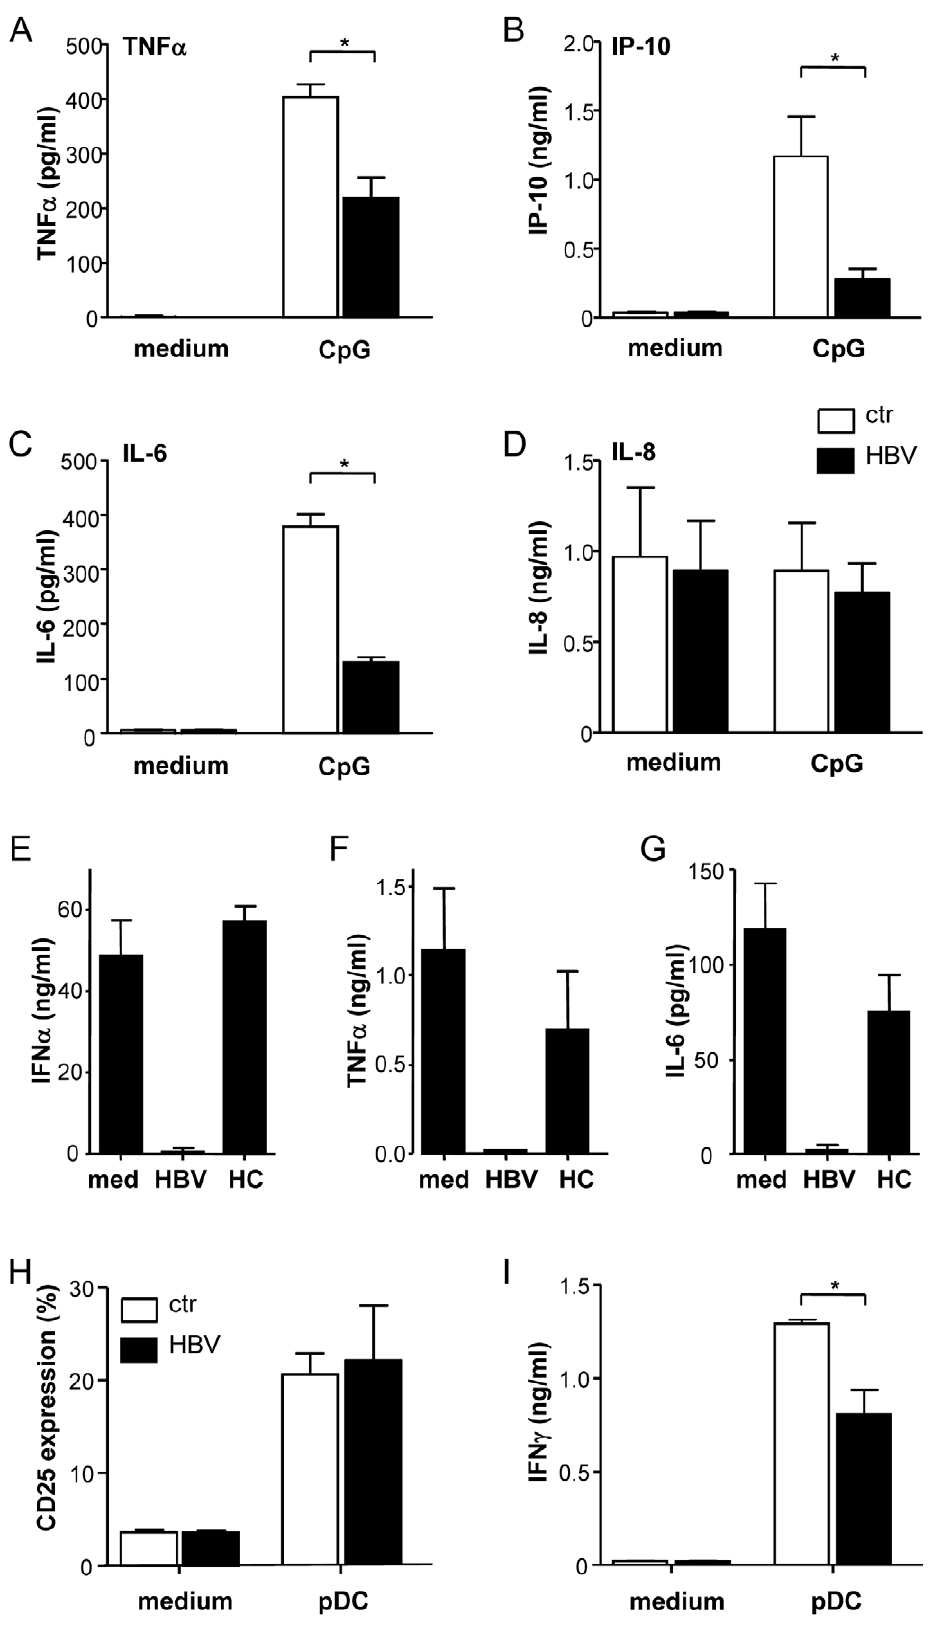
Figure 3. HBV inhibits cytokine production and pDC-induced NK cell activation. ABCD : Purified pDC were cultured with CpG in the presence or absence HepG2.215-derived HBV. Supernatants were analysed for TNF a (A), IP-10 (B), IL-6 (C) and IL-8 (D). Data demonstrate mean 6 SEM